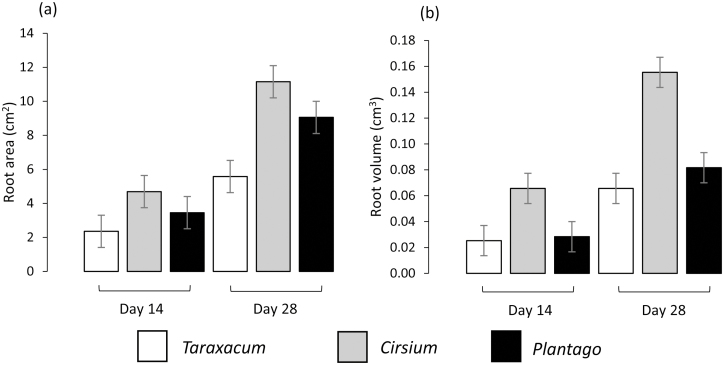
(a) Mean surface area and (b) volume of roots of Taraxacum officinale, Cirsium vulgare, and Plantago lanceolata grown for 14 d and 28 d in repacked soil columns with a bulk density 1.8 g cm–3. The data are derived from X-ray computed tomography segmentation and are means (±SE) of 6 replicates.